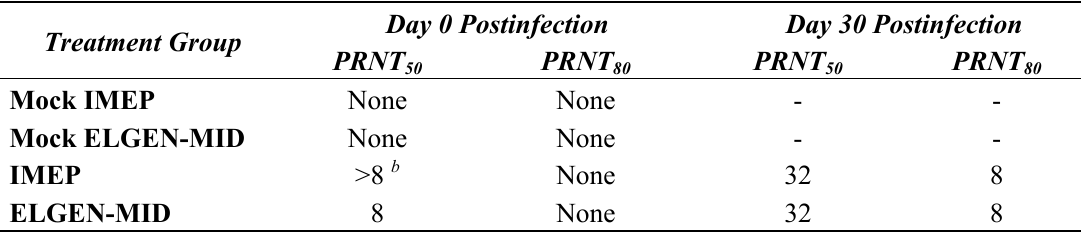
Table 2. Plaque-reduction neutralization test (PRNT) titers following vaccination (day 0) and infection with LASV (day 30) a